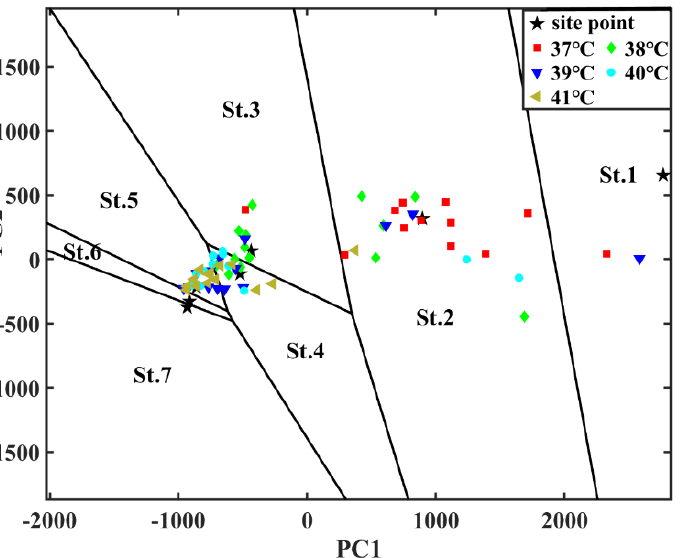
Figure 6. A distribution sample of the two main PCA components in the HRV of the BT at five water temperatures on a Voronoi diagram generated by EST Stages 1–7 (subject V).